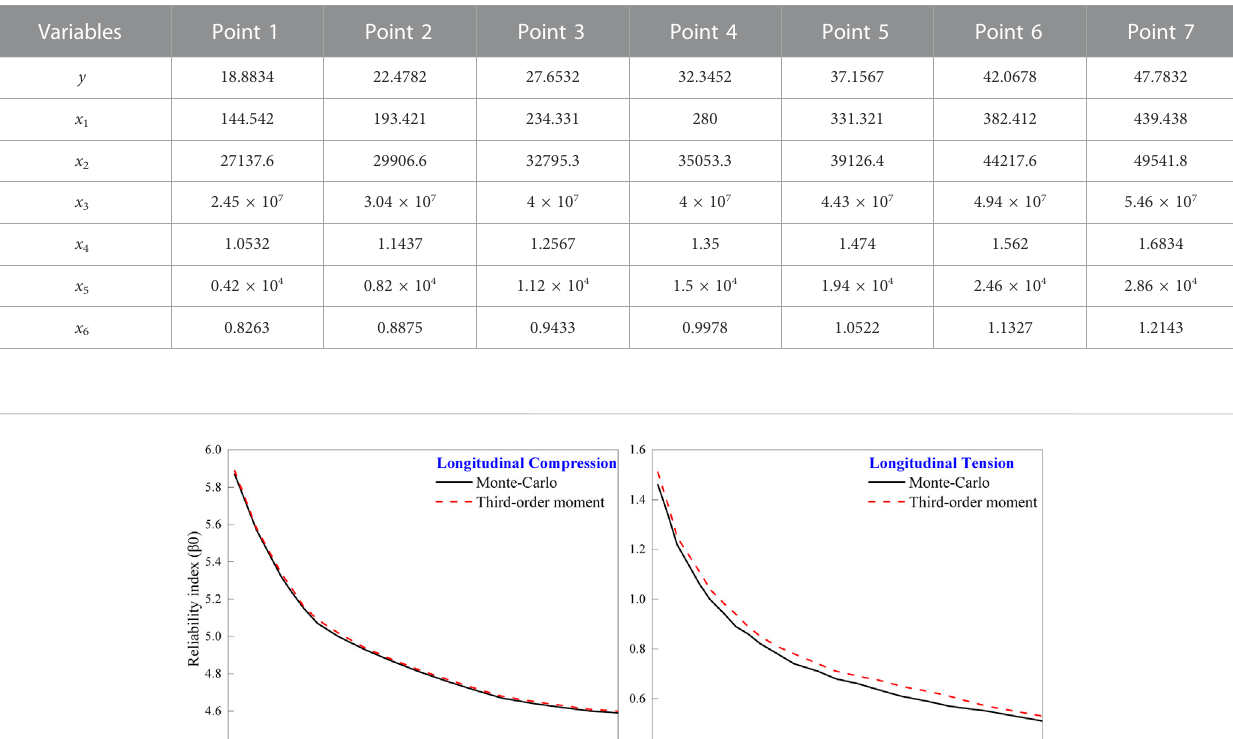
TABLE 4 Random variable seven-point inverse normal transition value.